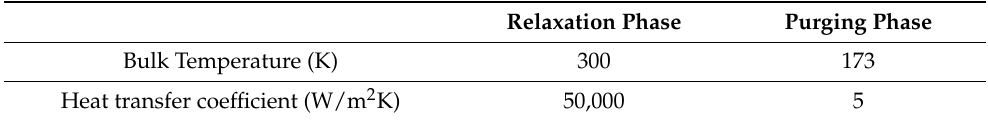
Table 8. Input data for the thermal analysis.